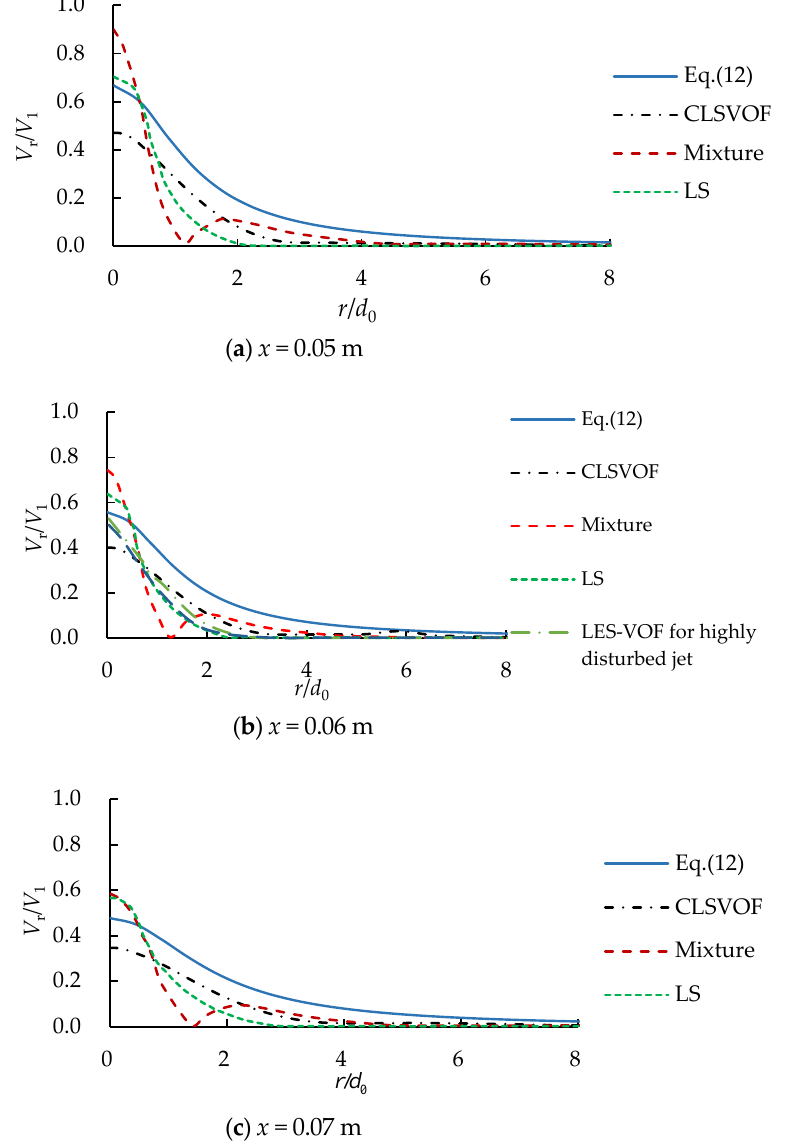
Figure 9. The V r / V 1 relationship with r/d 0 for V 0 = 2 m/s and L 1 = 0.025 m using Equation (12) and the LS, Mixture, CLSVOF, and LES-VOF methods at the sections of ( a ) x = 0.05 m, ( b ) x = 0.06 m, and ( c ) x = 0.07 m.